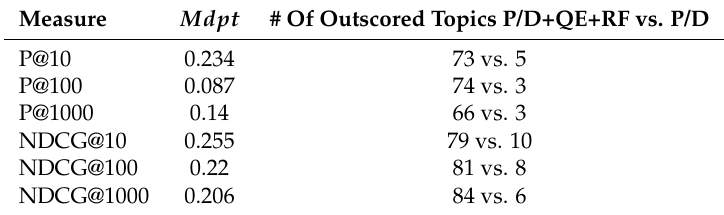
Figure 17. Scatter plots of Porter/Dirichlet with QE+RF vs. the same run without QE+RF: ( a ) P@10, ( b ) NDCG@10. Table 17. Dirichlet + QE + RF run vs. Dirichlet without QE+RF